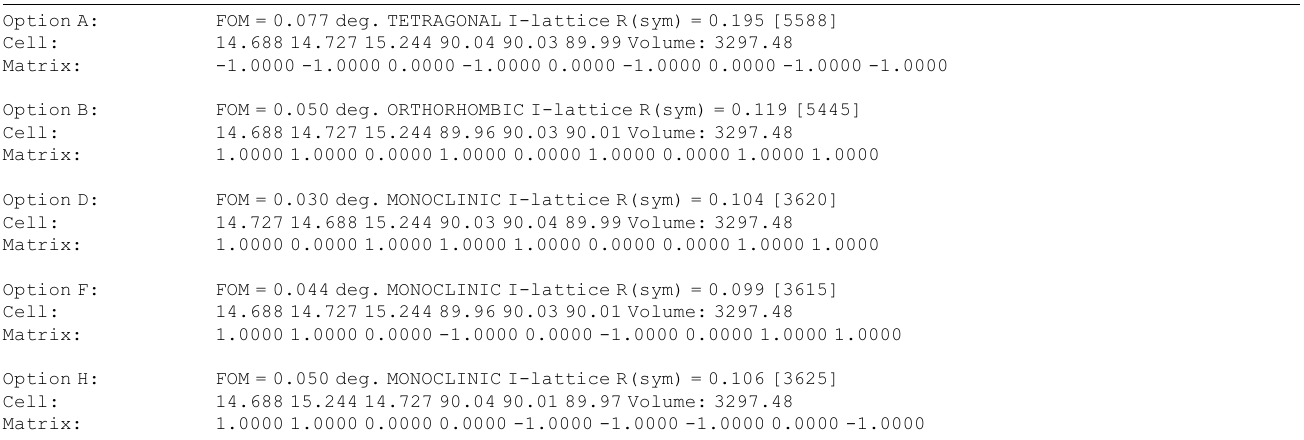
Table 4 A search for higher metric symmetry in SAXDUR using XPREP . Tetragonal- I was dismissed, in part due to its much higher R sym . All four remaining cells are pseudo-tetragonal. C -centred equivalents of the monoclinic- I cells are not shown.